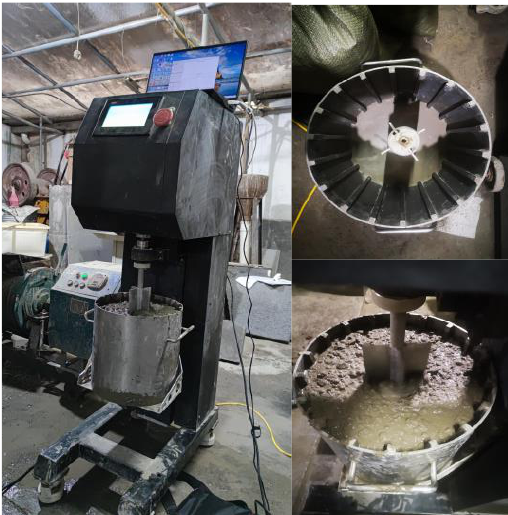
Figure 6. Rheometer measurement.